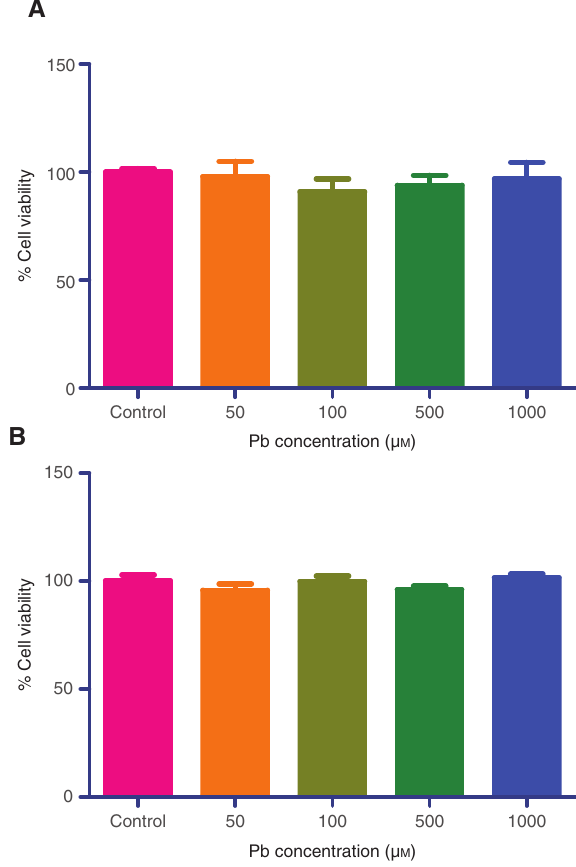
Figure 1: Cell viability after treatment of human lymphocytes with Pb acetate for 12